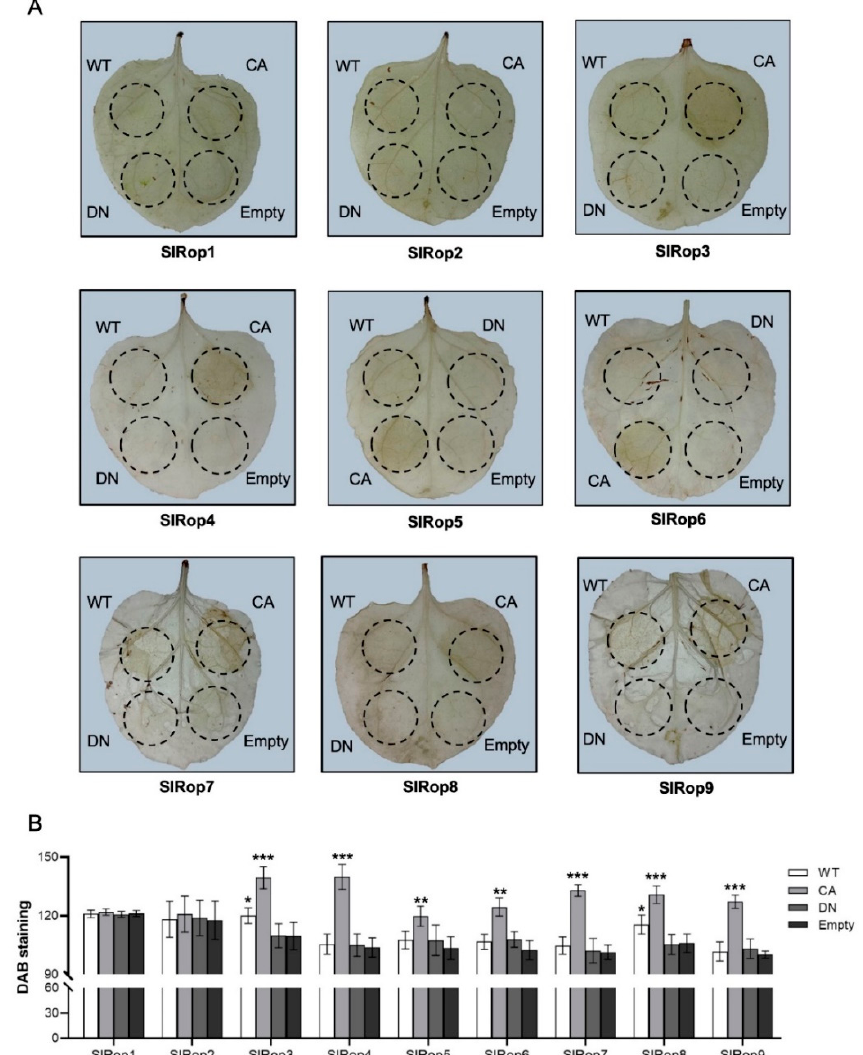
Figure 5. Role of tomato Rac/Rop-related small GTPases in ROS production. Nine free-tagged SlRops with different activation levels were transiently expressed in N. benthamiana to examine their ability to produce ROS. By 5 dpi, the agroinfiltrated leaves were stained with DAB, decolored using absolute ethanol. WT, wild type; CA, constitutively active; DN, dominant-negative; Empty, empty vector used as a negative control. ( A ), Photograph showed ROS production in situ. ( B ), Quantitative analysis of ROS production. Bars indicate DAB staining intensity relative to that observed after infiltration with negative control. Data are expressed as mean ± SD (one-way ANOVA; * p < 0.05; ** p < 0.01; *** p < 0.001; n = 8).